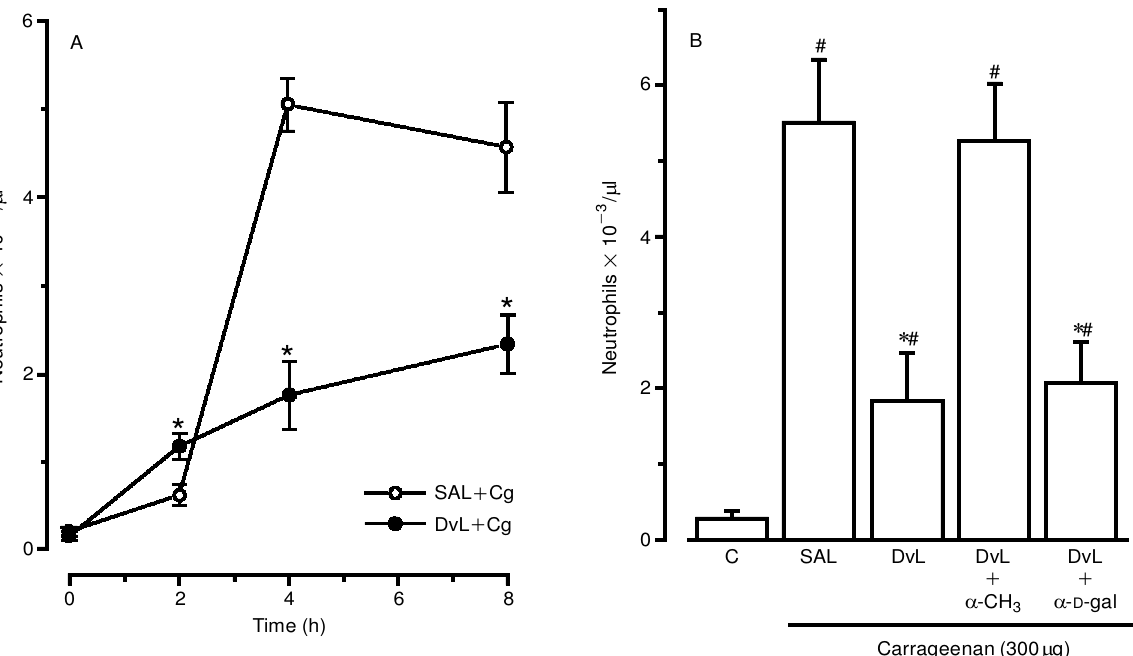
FIG. 3. Effect of D. violacea seed lectin (DvL) on carrageenan (Cg)-induced neutrophil migration into rat peritoneal cavities and the involvement of mannose/glucose residues on its inhibitory activity. (A) Time-course of Cg-induced neutrophil migration and the effect of DvL treatment (1 · 0 mg / kg in 0 · 1 ml / 100 g, i.v. 30 min before i.p. injection of 300 m g Cg). (B) The effect of 0.1 M a - D -methyl-mannoside ( a -CH 3 ) or a - D -galactose ( a - D -gal) in DvL inhibitory activity, 4 h after Cg-challenge. Control animals (C) received saline (0 · 1 ml / 100 g) both by i.v. and i.p. routes. SAL refers to animals that received saline i.v. and carrageenin i.p. Values are mean SEM for the number of animals used (n = 6). Indicates a signi® cant statistical difference when compared to the SAL group ( P , 0.05); # indicates a signi® cant statistical difference when compared to the C group ( P , 0.05) (ANOVA, Duncan’s